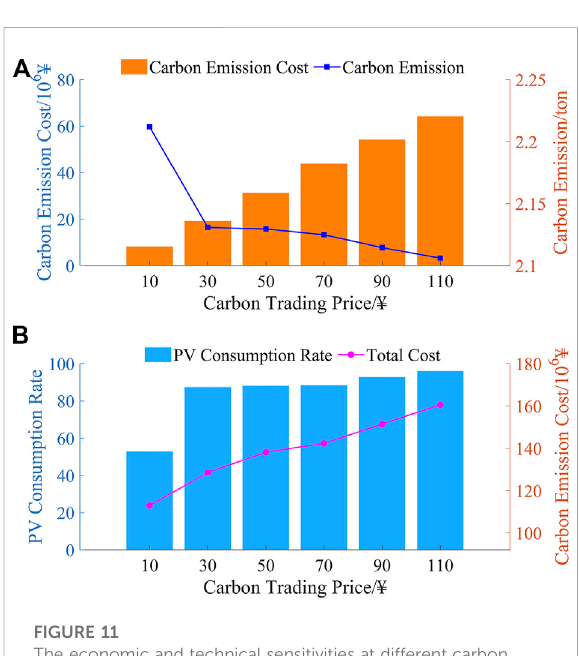
FIGURE 11 The economic and technical sensitivities at different carbon